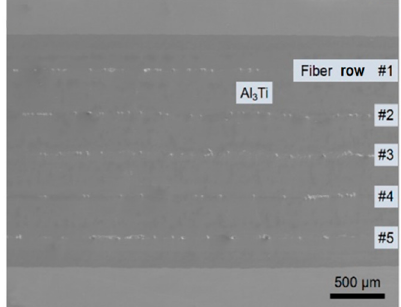
Figure 24. SEM micrographs of the Ti-(SiC f /Al 3 Ti)-laminated composite with five rows of SiC fiber reinforcements.